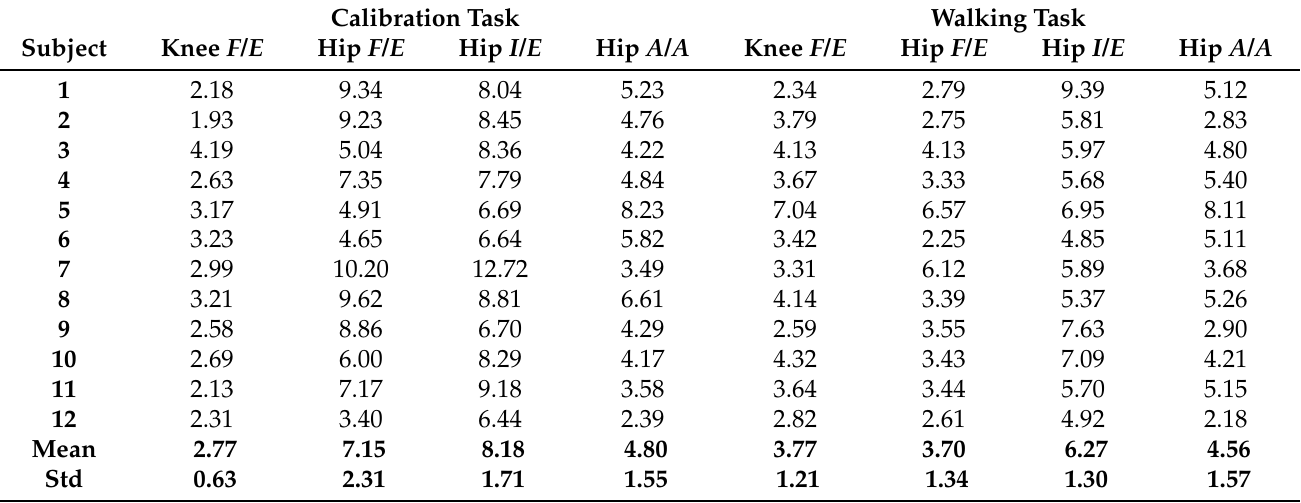
Table 2. RMSE (degrees) of relative IMU joint angles vs. mocap joint angles for both the calibration and walking tasks. F/E , I/E , and A/A refers to flexion/extension, internal/external rotation, and abduction/adduction of the joint, respectively. Values are the average value for the right and left